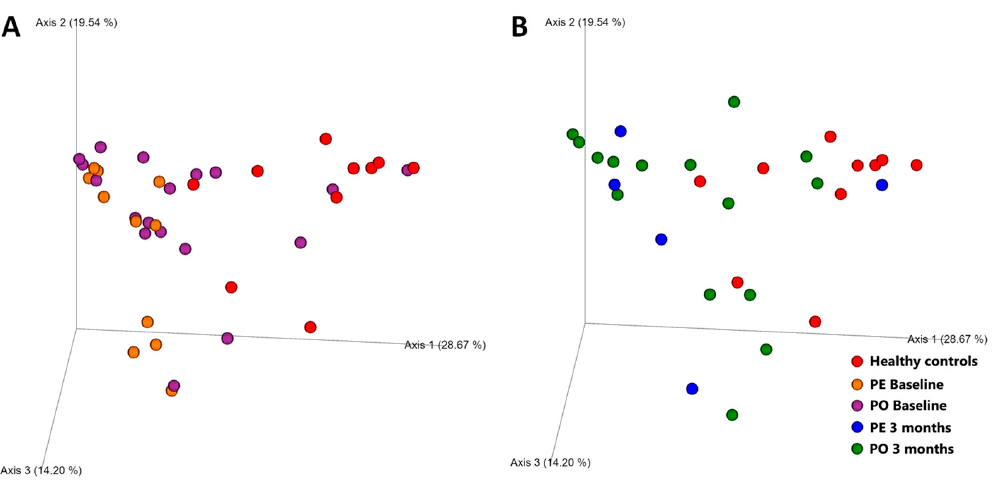
Figure 4. Abundance of key genera at baseline in healthy controls, in CE dogs with cobalamin deficiency, and in CE dogs with normocobalaminemia. Individual values are shown, and red lines indicate the median. * = q < 0.05; # = q < 0.1.